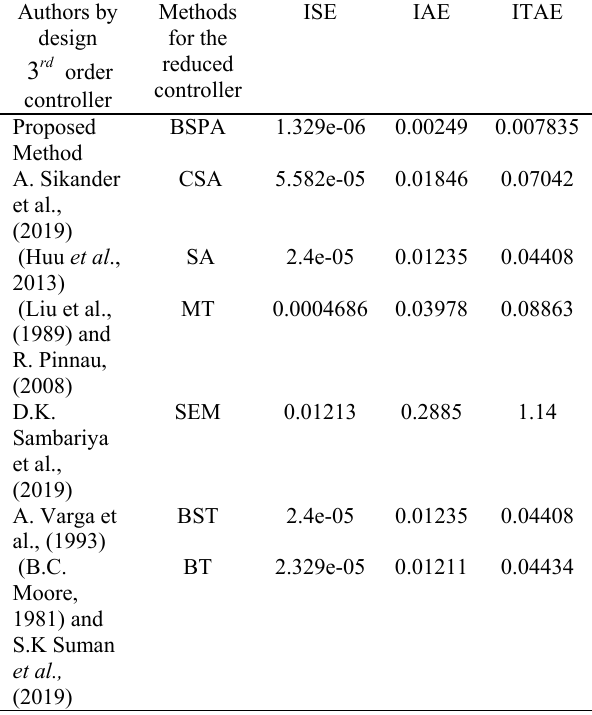
Table 7: Performance comparison of closed-loop bicyrobo using third order controllers with Case -2 Authors